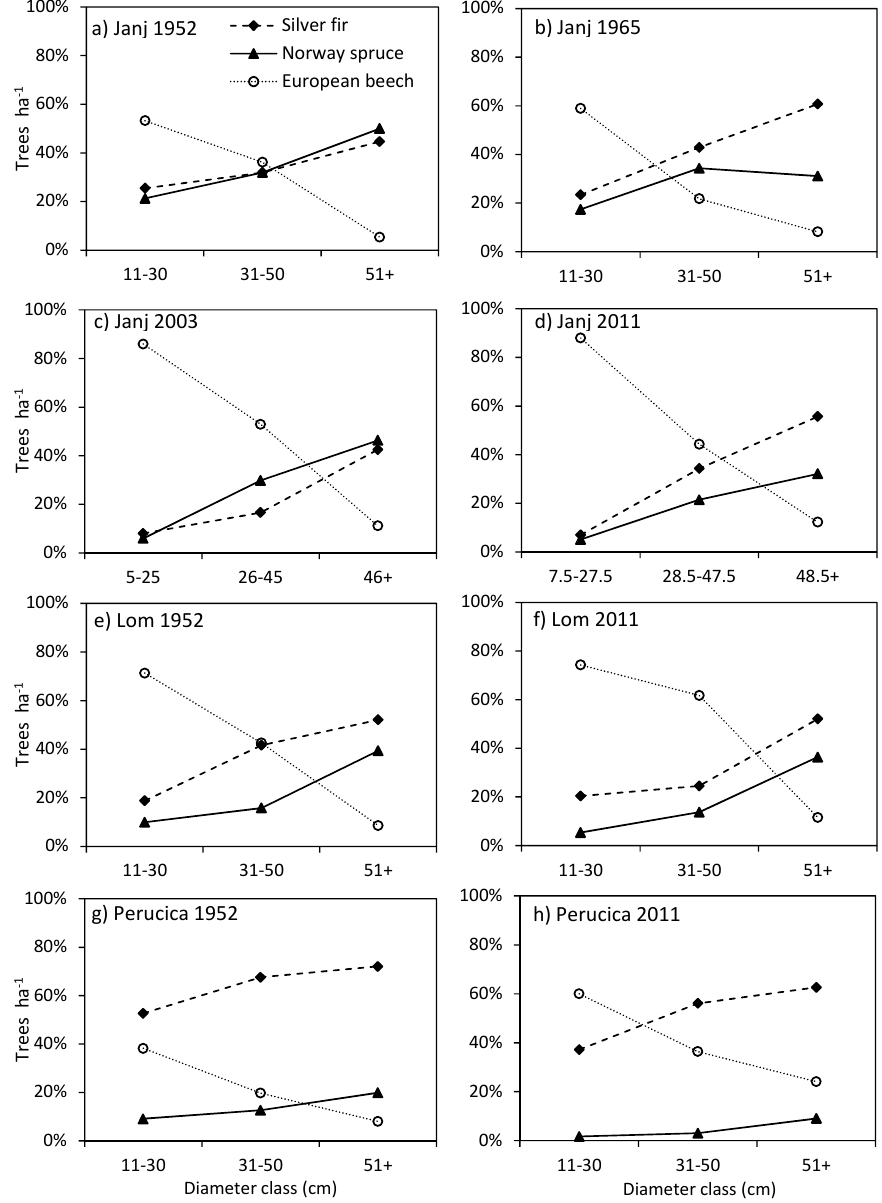
Figure 4. Changes in tree species composition with respect to density within extended dbh size classes in the Janj old-growth forest at different inventory years ( a – h ) and comparison with the Lom and Perucica old-growth forests. ( a ) Share of silver fir, Norway spruce and European beech in Janj old-growth forest in 1952 according to extended dbh classes; ( b–d ) Same data for Janj old-growth forest in 1965, 2003 and 2011, respectively; ( e , f ) Same data for Lom old-growth forest in 1952 and 2011, respectively; ( g , h ) same data for Perucica old-growth forests in 1952 and 2011,